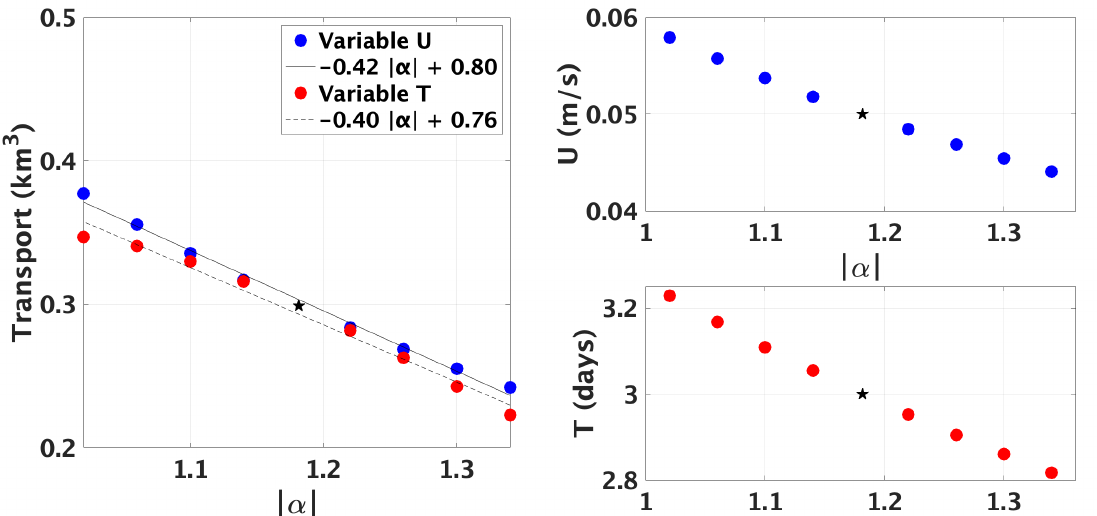
Figure 5. ( Left ) Cross-shelf transport across the surface Ψ = 0 for a variety of values of α , as defined in Table 2. The blue data points correspond to changes in the denominator and red data points to changes in the numerator. Lines show linear fits to the data series separately. ( Right, top ) Values of U corresponding to the values of | α | used to derive the blue data points. ( Right, bottom ) Values of T corresponding to the values of | α | used to derive the red data points. The black star in all panels shows the data point for the base